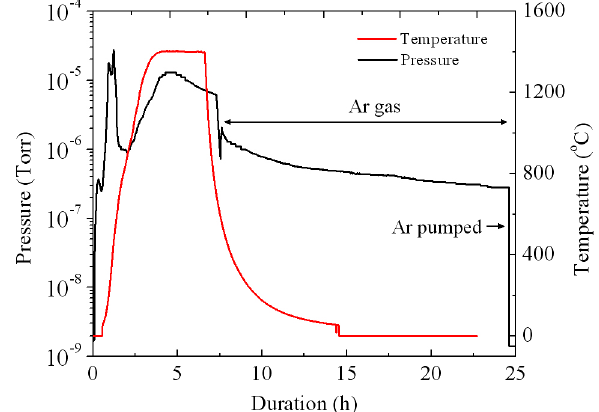
FIG. 2. Temperature and total pressure during heat treatment at